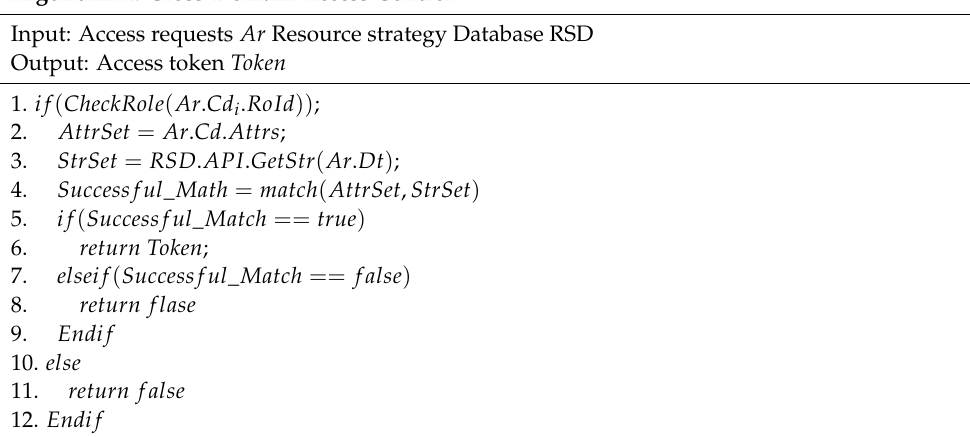
Algorithm 2: Cross-Domain Access